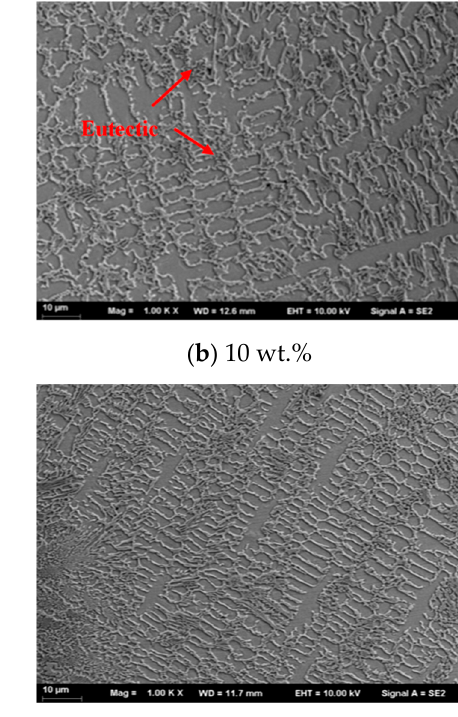
Figure 2. Non-destructive test results of the laser cladded Ni45 + high-carbon ferrochrome coatings.